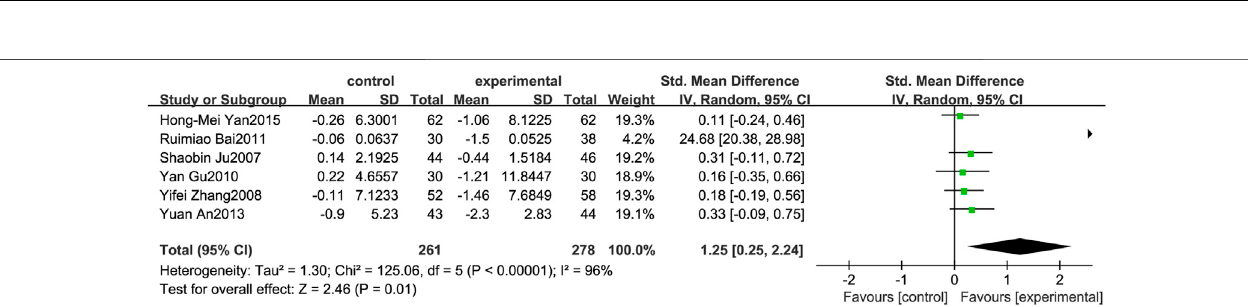
Frontiers in Pharmacology |